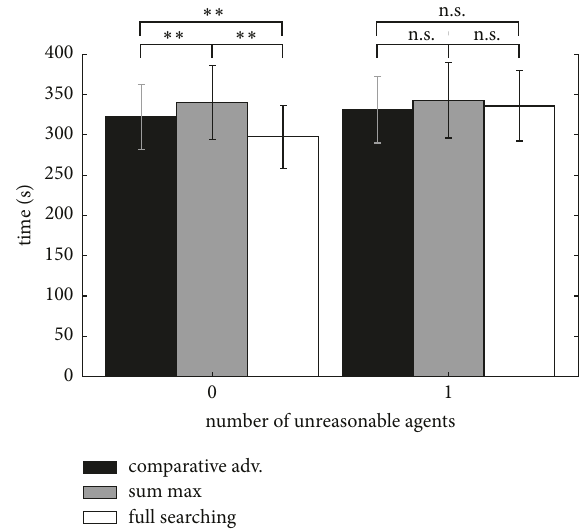
Figure 15: Makespan in the unreasonable condition. ∗∗ 𝑝 < .01 , ∗ 𝑝 < .05 , and + 𝑝 < .1 . A significant 𝑝 value indicates that a significant difference in prescribing exists between the conditions. Thelower 𝑝 valueindicatesastrongsignificantdifference.n.s.means no significant difference between the